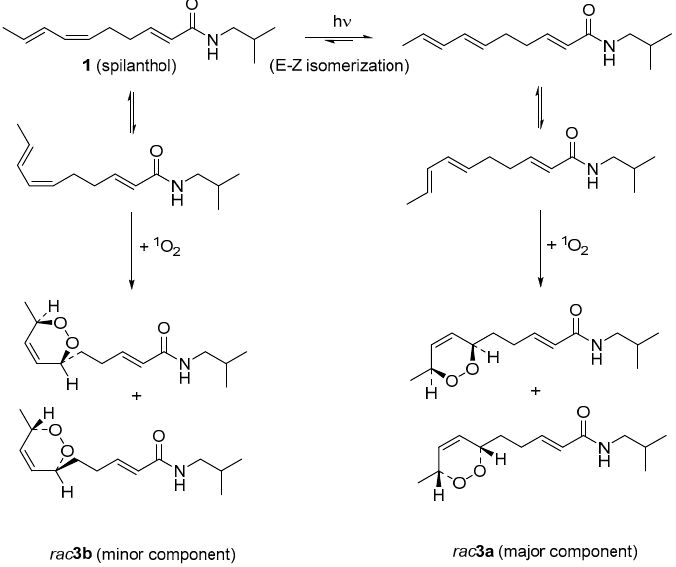
Figure 3. Hypothetical routes of formation for the stereoisomers of compound 3 .